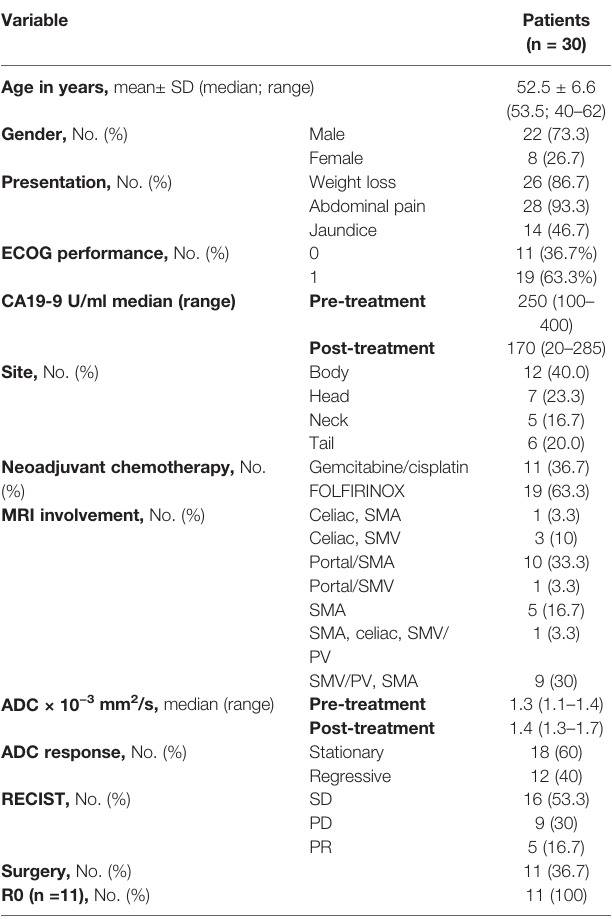
TABLE 2 | General characteristics of the study group (n=30).